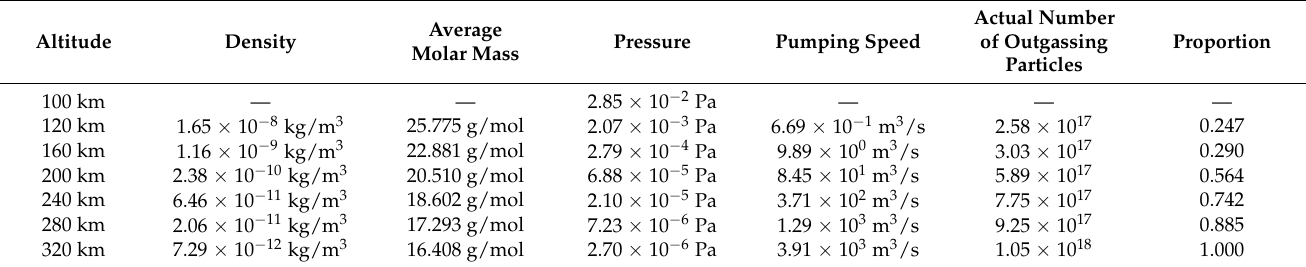
Table 9. Data related to outgassing at different altitudes under the LM case.